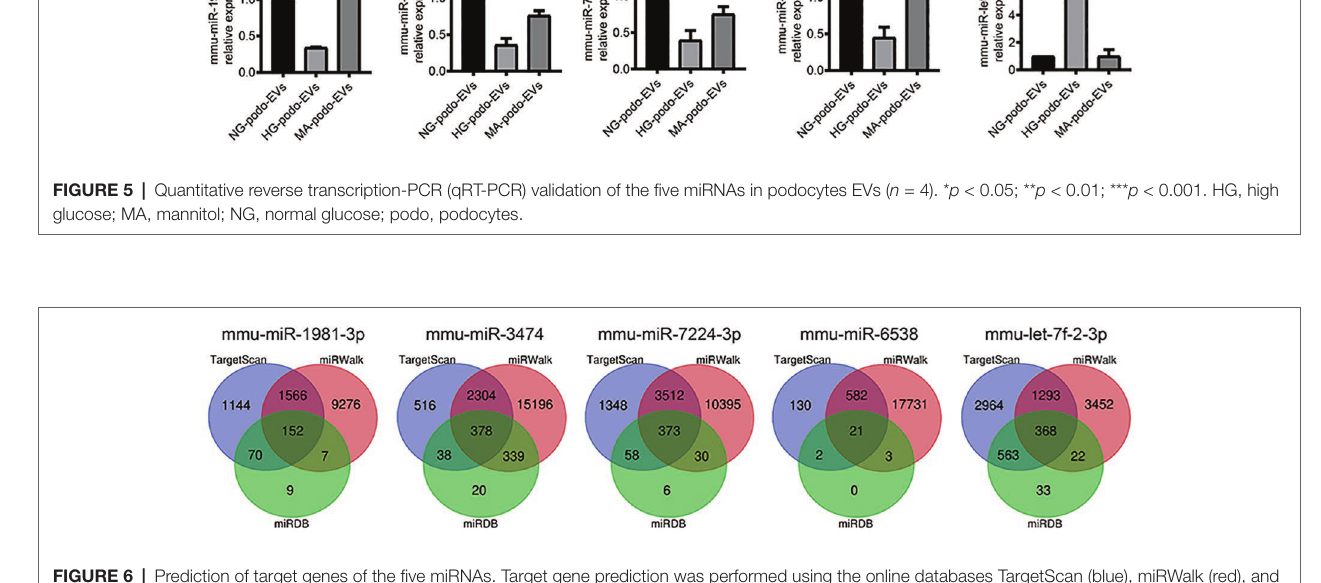
FIGURE 6 | Prediction of target genes of the five miRNAs. Target gene prediction was performed using the online databases TargetScan (blue), miRWalk (red), and miRDB (green). Genes predicted in all three databases (overlapping genes) were selected for further bioinformatics analysis.